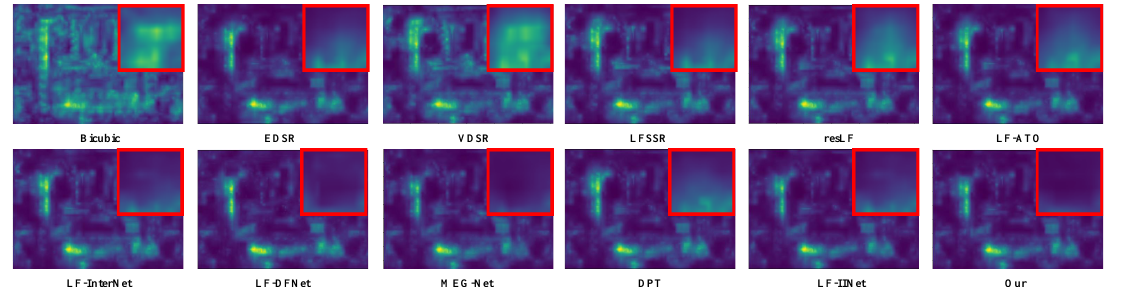
Figure 9. Visual results of 4 × SR.